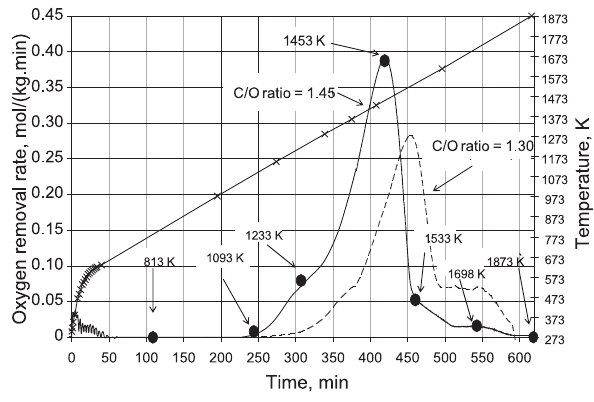
Fig. 4: Temperature programmed reduction of synthetic rutile in the H -N gas mixture. Temperature was ramped from 623 to 1873 K at 2 2 2 K/min. Samples in the highlighted points were examined by LECO and